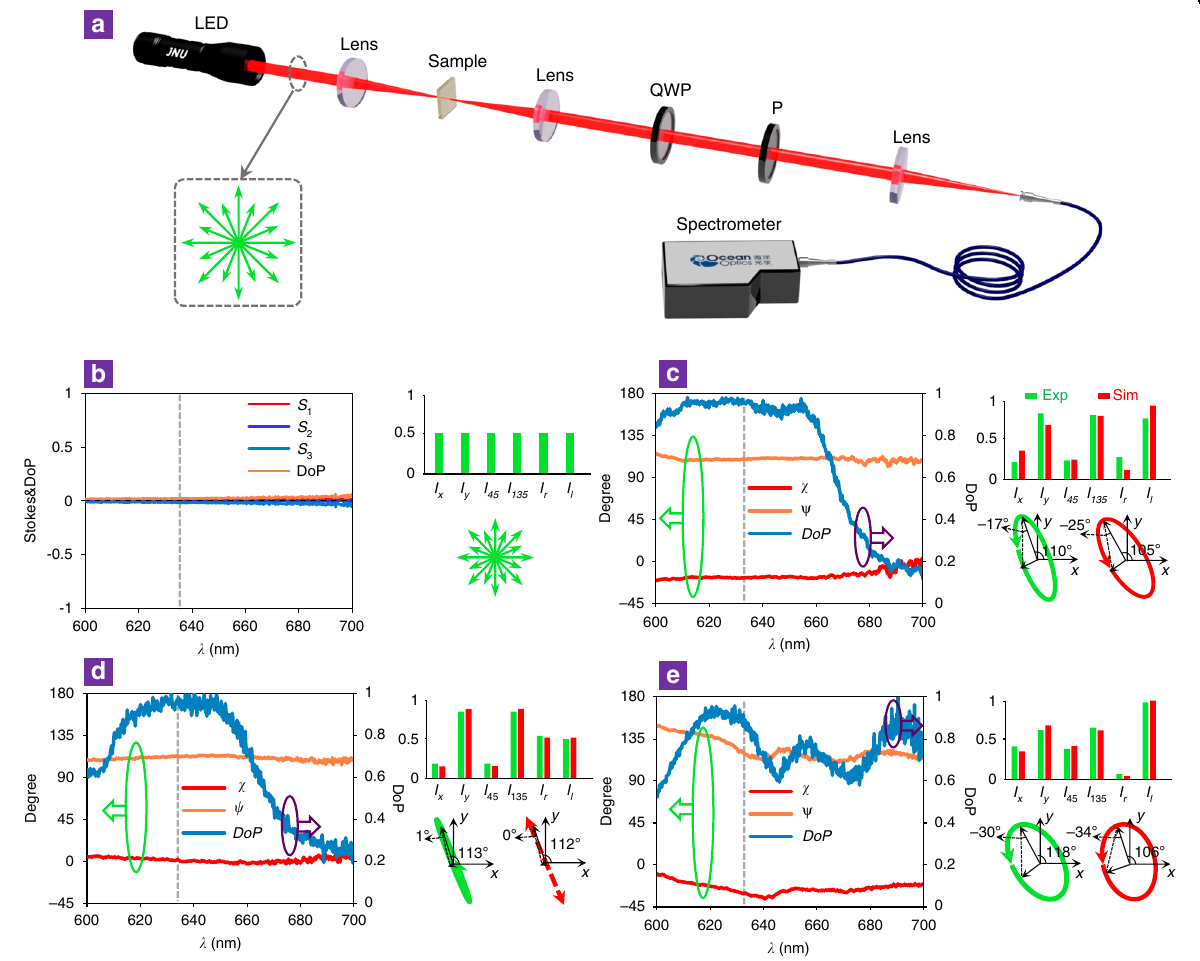
Fig. 4 Demonstration of all-in-one APCD metasurfaces acting on unpolarized incident light. a Experimental setup for the DoP measurement of transmitted light from APCD metasurfaces illuminated by an unpolarized LED source. b Measured Stokes parameters and the DoP of the incident beam directly from the LED source. The histogram shows the measured intensities of different electric components at a wavelength of 633 nm. The unpolarized light beam is represented by the green arrows. c – e Measured main axis angle ψ , ellipticity angle χ and DoPs of the transmitted beams through the designed c elliptical, d linear and e circular dichroism metasurfaces. The histograms show the measured (green) and simulated (red) intensities of different electric components at a wavelength of 633 nm. The green polarization ellipses represent polarization states derived from measured Stokes parameters at 633 nm, which are consistent with the simulated states (red